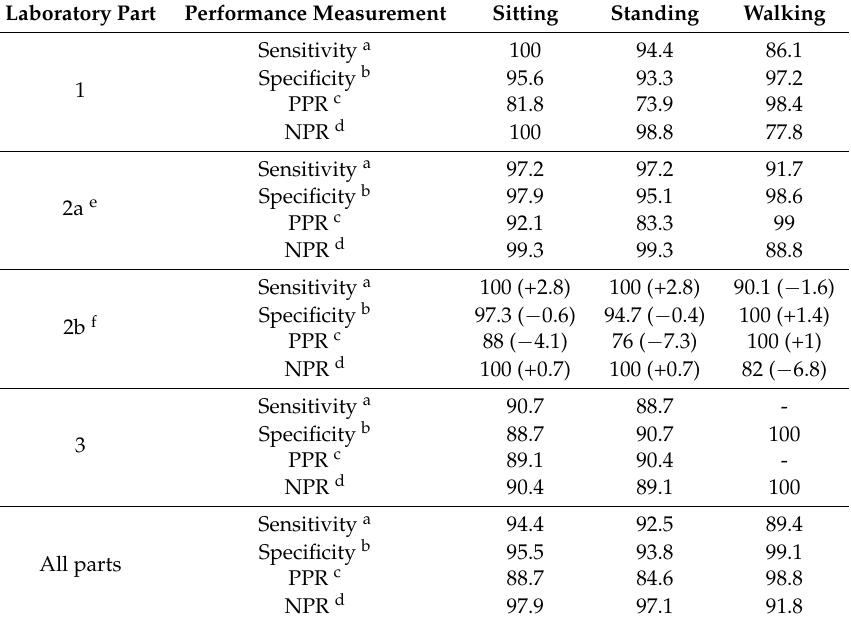
Table 5. Sub-study: performance of the ActiGraph with direct observation as criterion